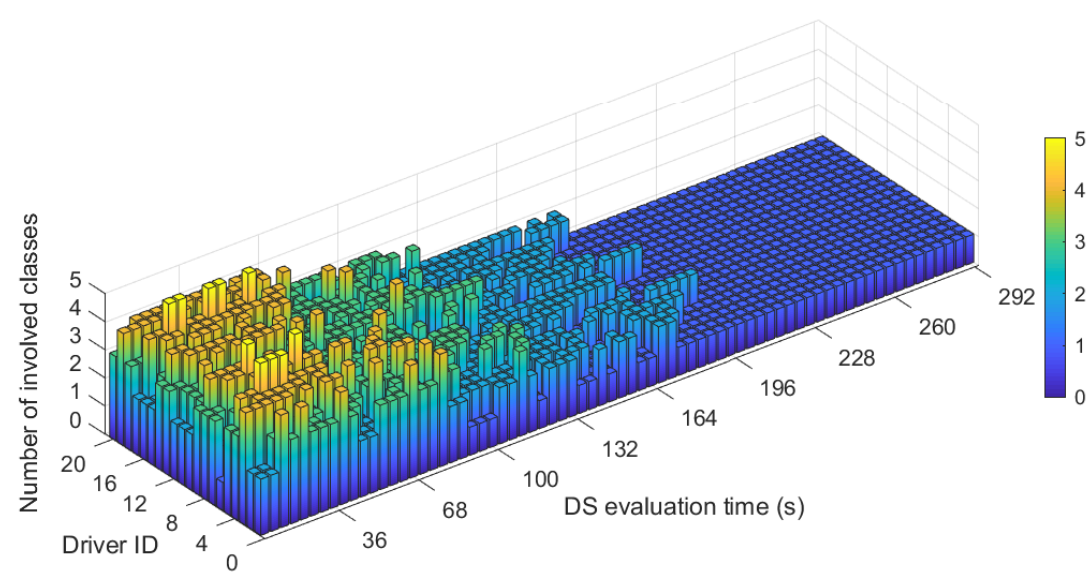
Figure 12. Three-dimensional bar diagram of the number of classes identified, depending on the evaluation time for each